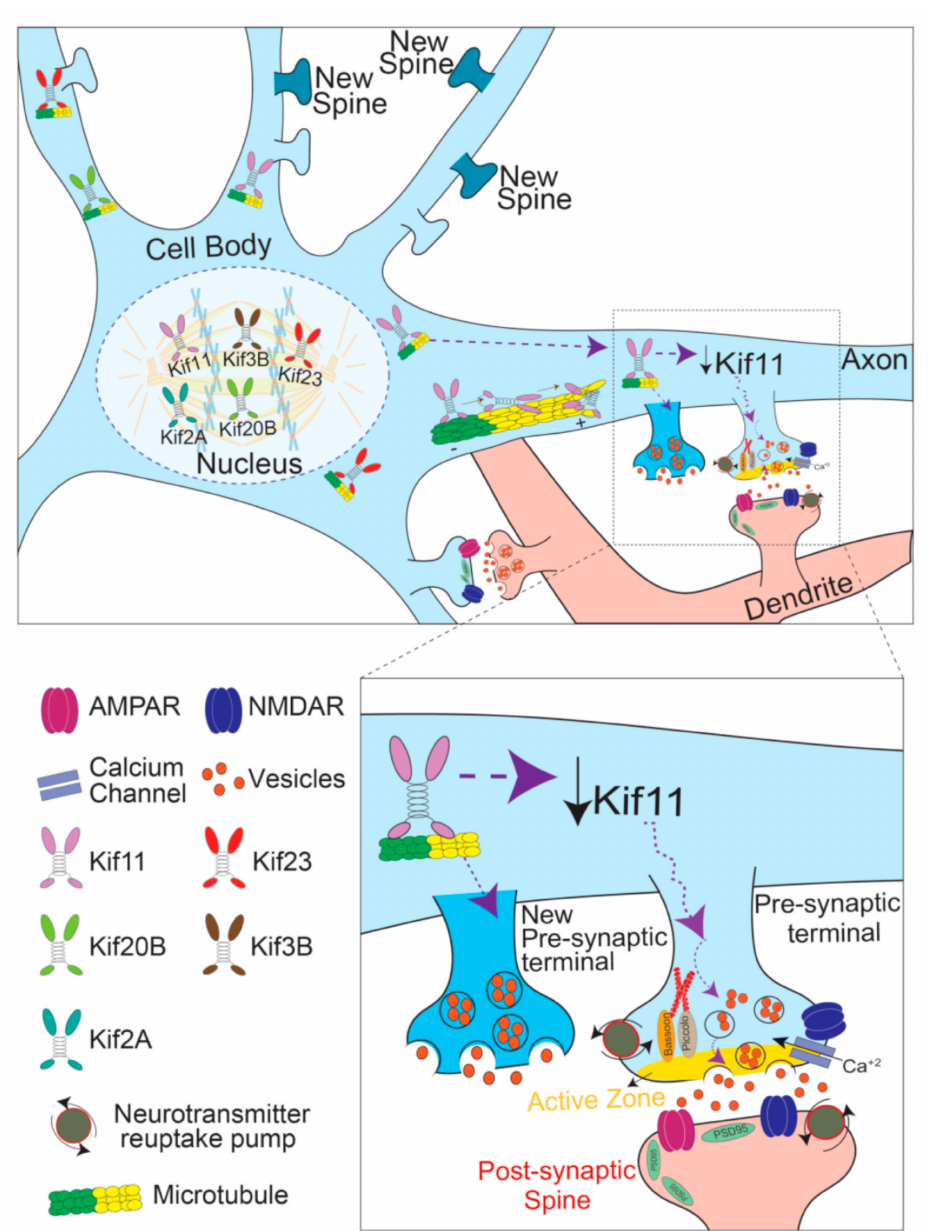
Figure 1. Cartoon illustration of known functions of mitotic kinesins in post-mitotic neurons. Functions of Kifs during cell division are depicted in the center surrounded by a dotted circle: KIF11/KIF2A/KIF3B/KIF20B/KIF23 have several key roles during mitosis including force gen- eration and cargo trafficking. In the cell body: KIF11/KIF20B/KIF23 regulate microtubules by modulating their growth rate and stability. The inset shows the role of KIF11 in modulating synapse function. A reduction of KIF11 causes an increase in excitatory synaptic transmission and synapse density [12]. Dotted arrows represent unknown